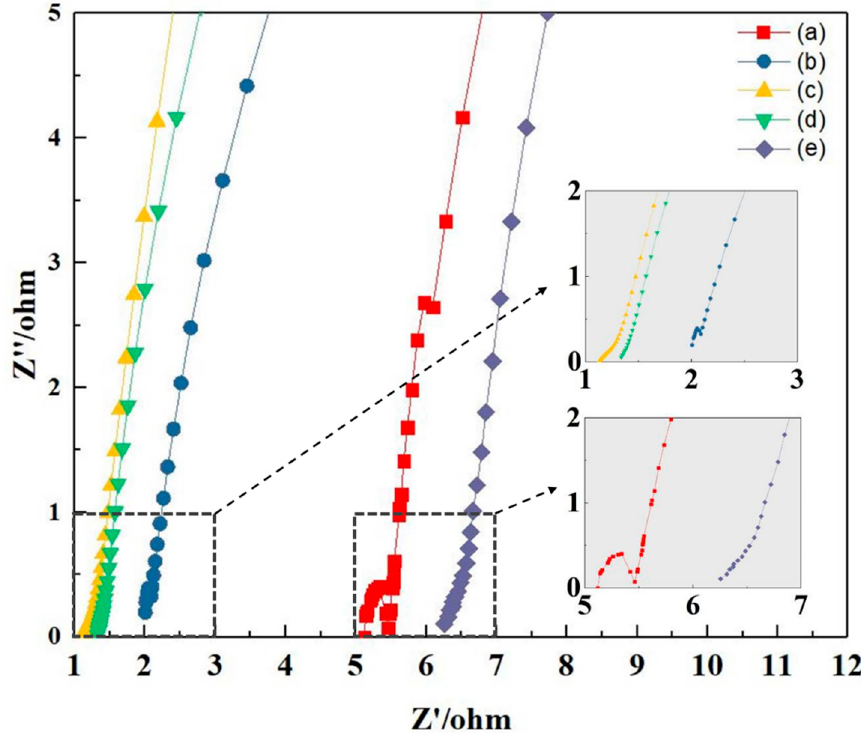
Figure 9. Nyquist plots of the Mn-Ni-O electrodes. Samples (a), (b), (c), (d), and (e) denote the samples with electroplating Mn: Ni ratio of 1:0, 1:0.25, 1:0.67, 1:4, and 0:1 respectively.